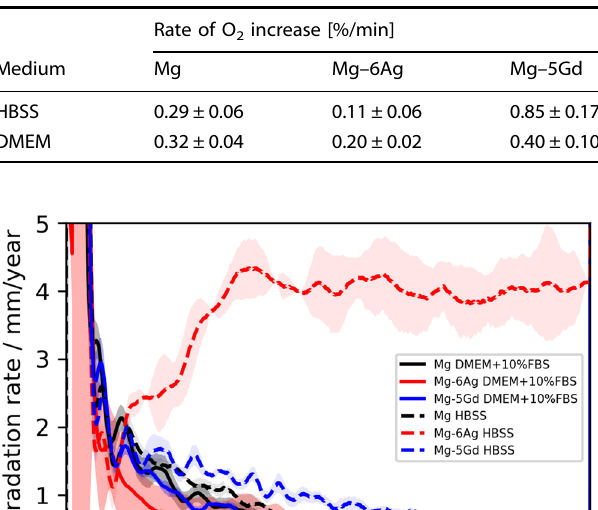
Table 1. Mean fi tted rate (±standard deviation) of O 2 increase at the metal surface measured during Mg alloy degradation in two different